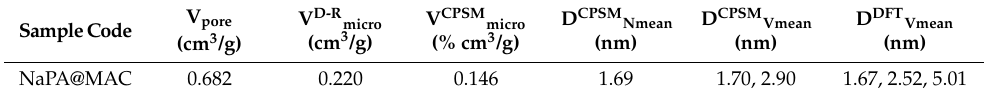
Table 1. Pore structure characterization results derived from Dubinnin–Raduskevitch (D-R) method, DFT model, and the simulation of the overall N 2 adsorption–desorption hysteresis loop by CPSM model.